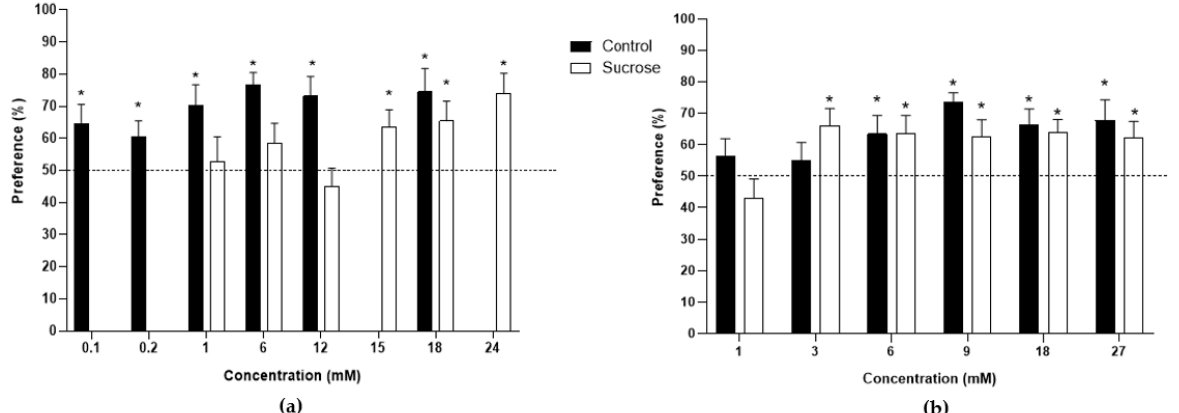
Figure 1. Bar plots of the preferences of pigs from control and sucrose groups: ( a ) Sucrose solutions; ( b ) MSG solutions. The dotted line represents the neutral value of 50% of preference. Asterisks highlight the values significantly ( p < 0.05) higher than 50%.